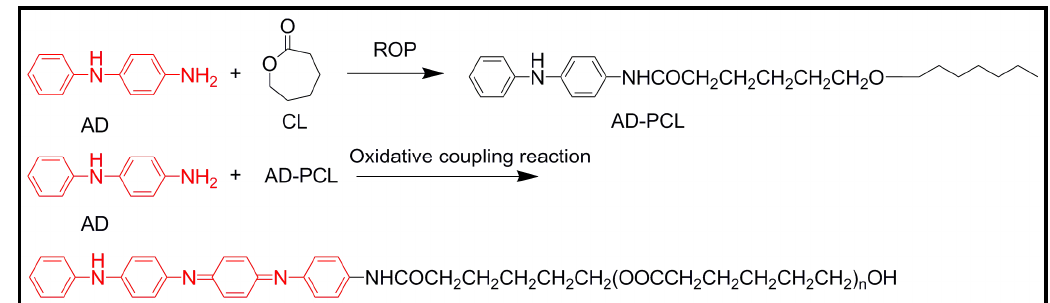
Figure 10. Two-step approach to prepare degradable and conductive block copolymers having aniline tetramer end groups.